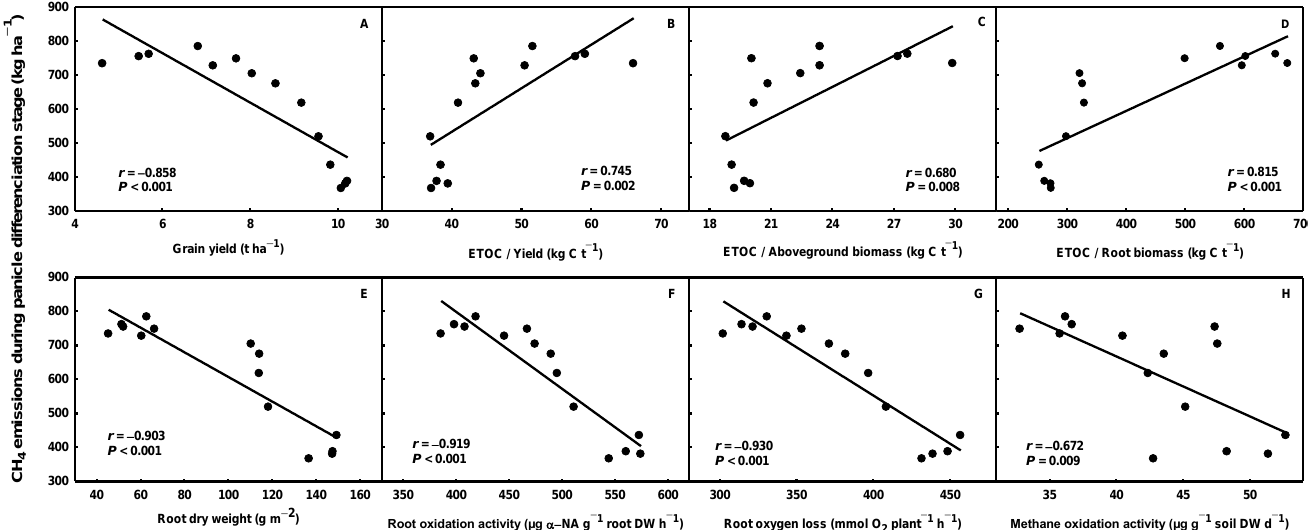
Figure 5. Relationships between cumulative CH 4 emissions in panicle differentiation and grain yield (A), root exudation (B, C, D), root physiological traits (E, F, G), and methane oxidation potential (H) ( A ), root exudation ( B – D ), root physiological traits ( E – G ), and methane oxidation potential ( H ) in in rhizosphere soil. rhizosphere